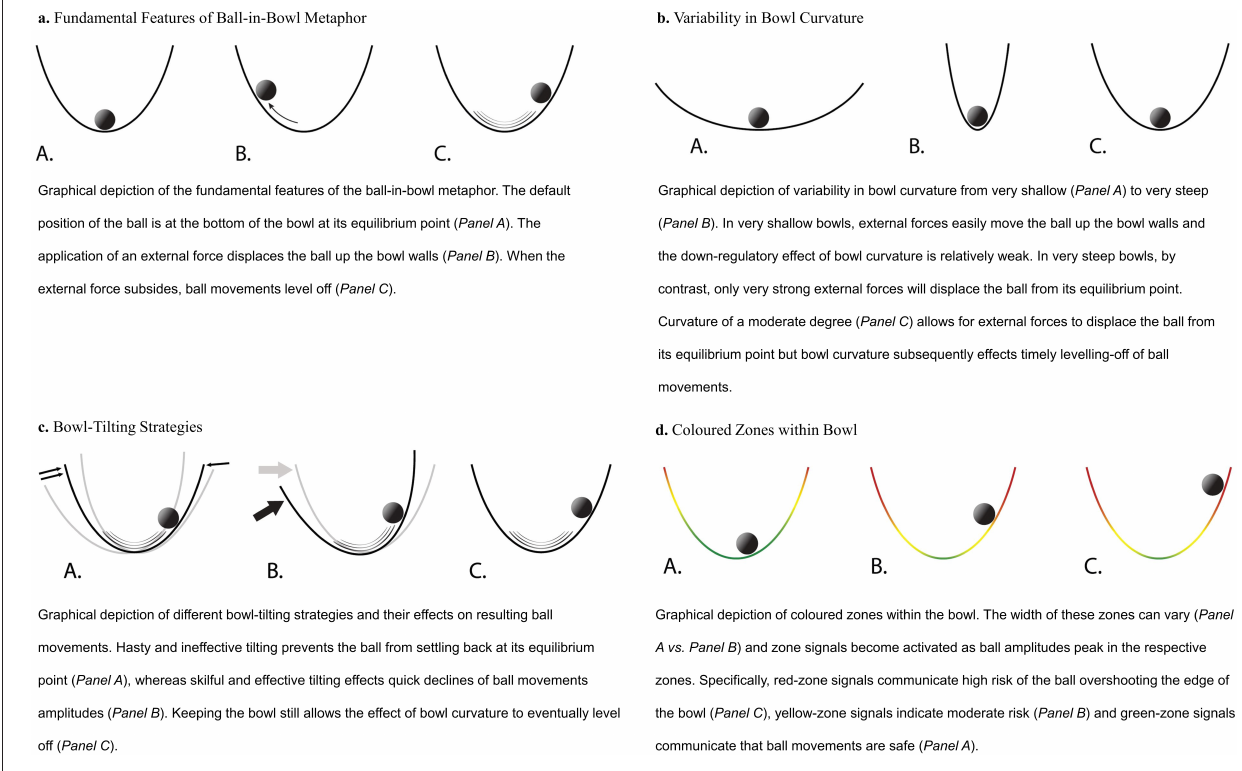
adapted ball-in-bowl metaphor onto the corresponding domains of dysregulated emotion (for an overview, see Table 1 ).